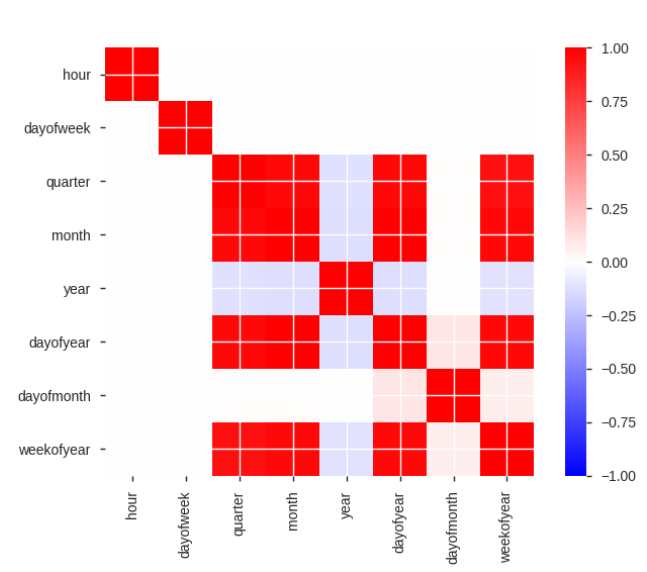
Figure 12. correlation graph of train data.